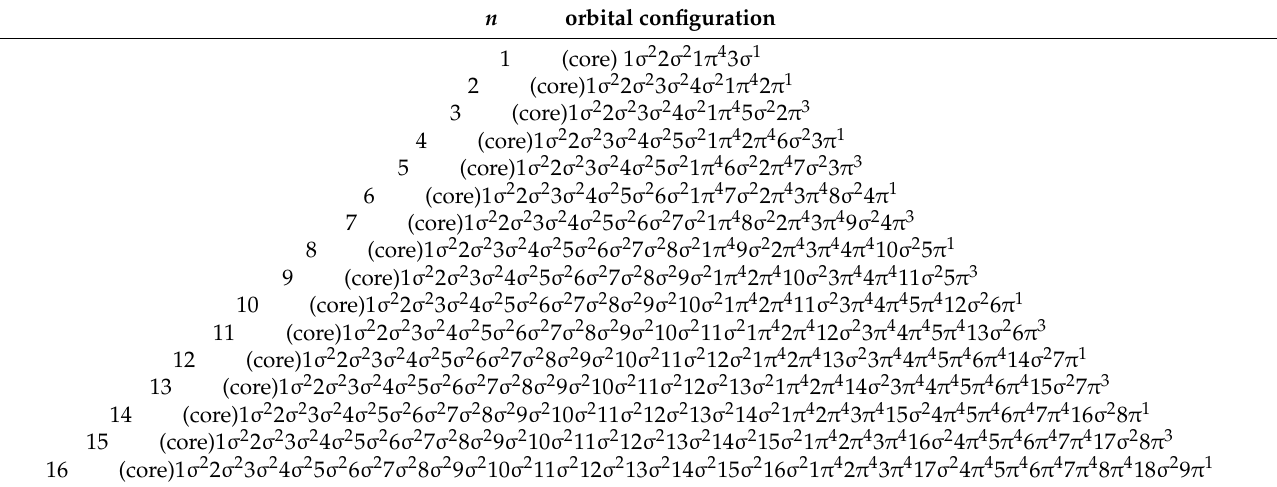
Table 8. Valence orbital configuration of C n Sb. n orbital configuration